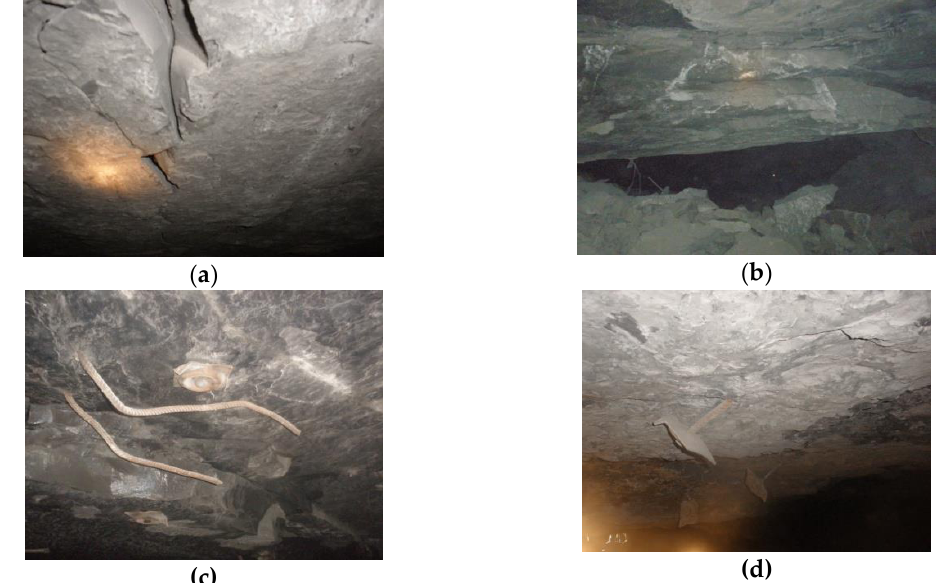
Figure 1. Impact of rock mass tremors on the condition of the room excavation and the rock bolt support: ( a ) Fissure in the roof; ( b ) Local roof falls; ( c ) Break in the bolt material continuity; ( d ) Sliding of the bolts from the hole